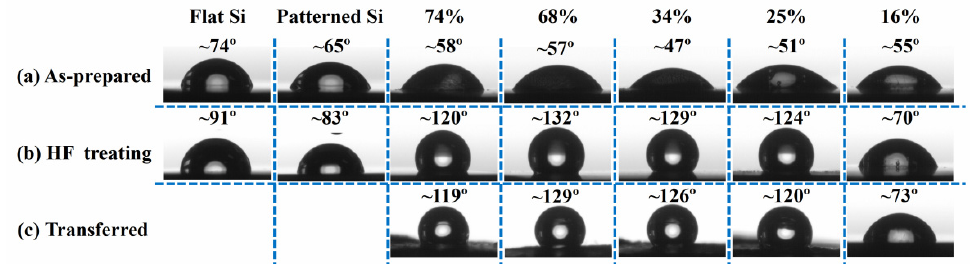
Figure 4. Water CAs on flat Si, patterned Si, and PSi films ( a ) as prepared, ( b ) after HF etching, and ( c ) after transfer onto a tape. The porosity is marked on top of each image. ( c ) after transfer onto a tape. The porosity is marked on top of each